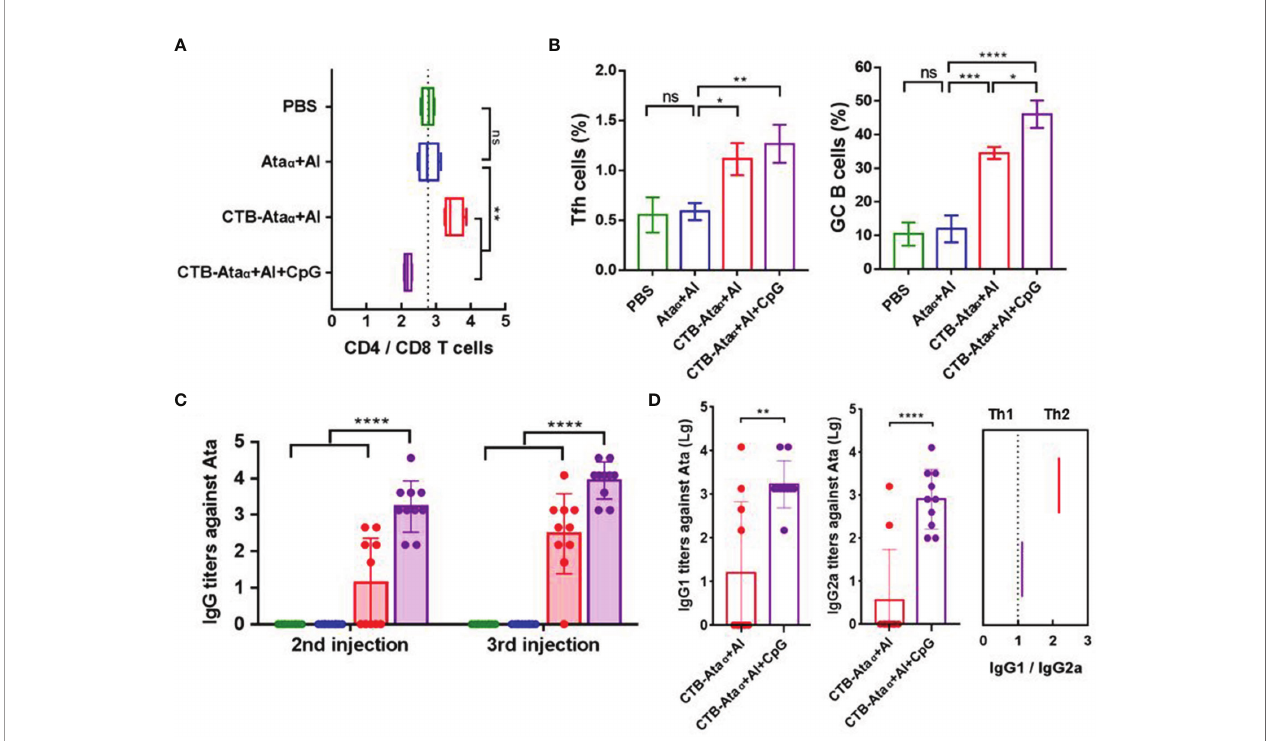
FIGURE 5 | Immunostimulatory effects of CpG. (A) The ratio of CD4 + /CD8 + T cells on day 7 after the second injection. (B) The proportion of Tfh cells (CXCR5 + PD- 1 + among the CD4 + cell population) and GC B cells (GL7 + CD95 + among the B220 + cell population) in dLNs on day 7 postvaccination. (C) Ata a -speci fi c IgG titers